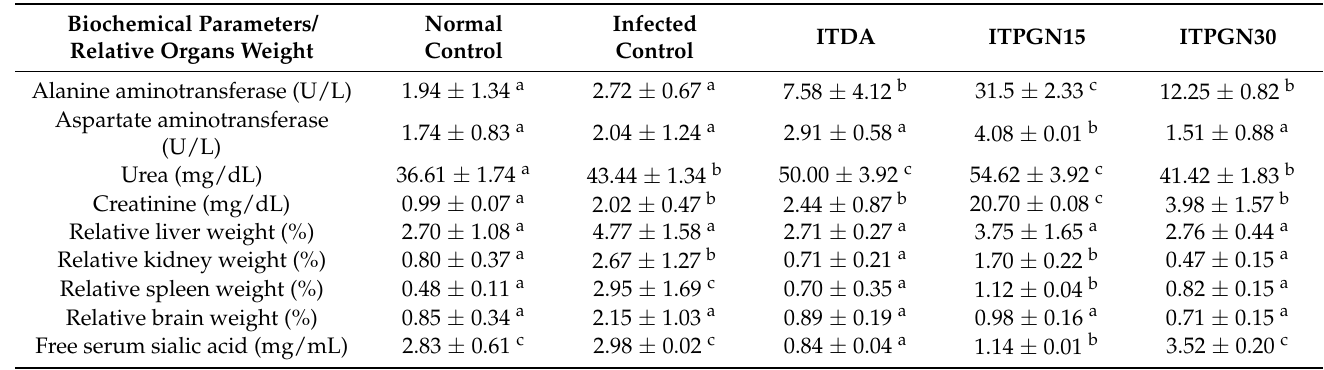
Table 1. Effects of oral treatment with phloroglucinol on biochemical parameters and relative organs weight of T. congolense -infected